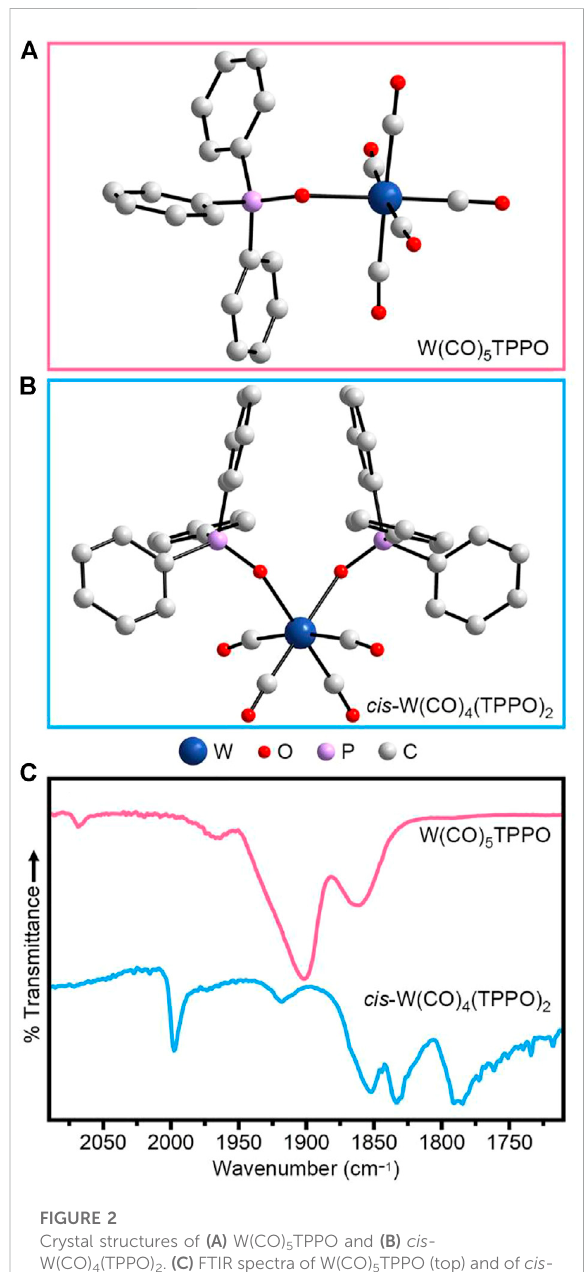
FIGURE 2 Crystal structures of (A) W(CO) 5 TPPO and (B) cis - W(CO) 4 (TPPO) 2 . (C) FTIR spectra of W(CO) 5 TPPO (top) and of cis - W(CO) 4 (TPPO) 2 (bottom)